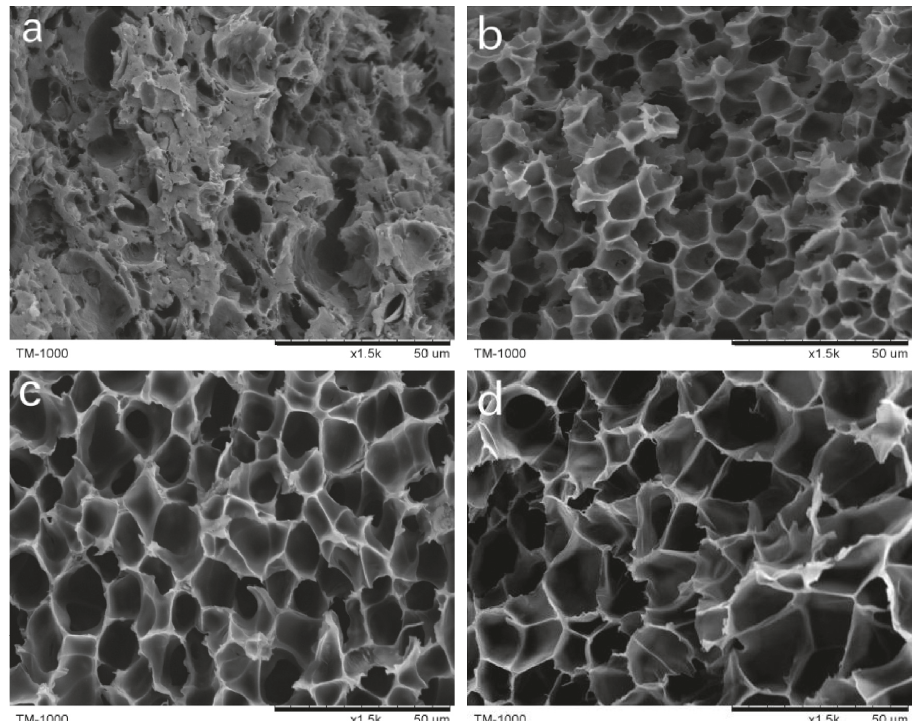
Figure 6: Cell structure of foaming material at different foaming temperatures (2h, 16MPa): (a) foaming temperature 90 ° C, (b) foaming temperature 110 ° C, (c) foaming temperature 130 ° C, and (d) foaming temperature 150 ° C.